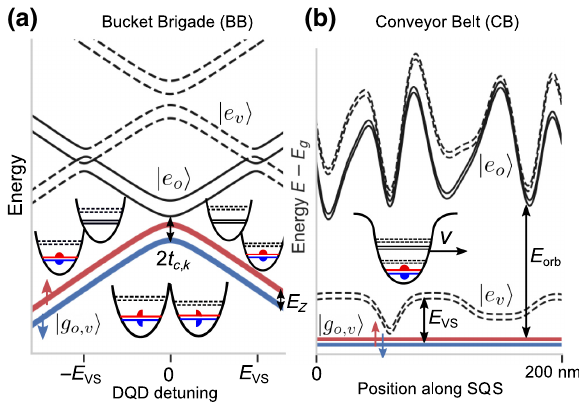
FIG. 3. Schematic picture of the energy spectrum during trans- fer of spin superposition in the presence of orbital (ground and first excited only), valley, and spin degrees of freedom, as a function of (a) DQD detuning (cid:5) in a single transition between the QDs in bucket brigade (BB), (b) position along the SQS in the conveyor belt (CB). We denote excited valley states | e v (cid:7) using dashed line and the joint ground state of orbital and val- ley degrees of freedom | g o , v (cid:7) by thicker: blue (spin down) and red (spin up) line. In the insets, we illustrate mechanism of elec- tron shuttling in each mode, note that in contrast to BB mode the charge transfer in CB does not require effectively adiabatic evolution in the lowest energy levels. In the conveyor belt (b), we plot the energy difference between excited and ground orbital levels, including expected electrostatic disorder (see Sec. III B). We also include the modification of energy spectrum due to atomistic steps (left kink) and a smooth interface gradient (right kink), that lead to temporal reduction of valley splitting E VS